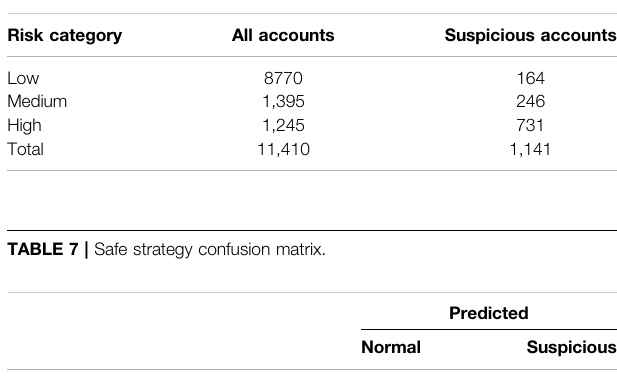
TABLE 6 | Risk categorisation of test observations.